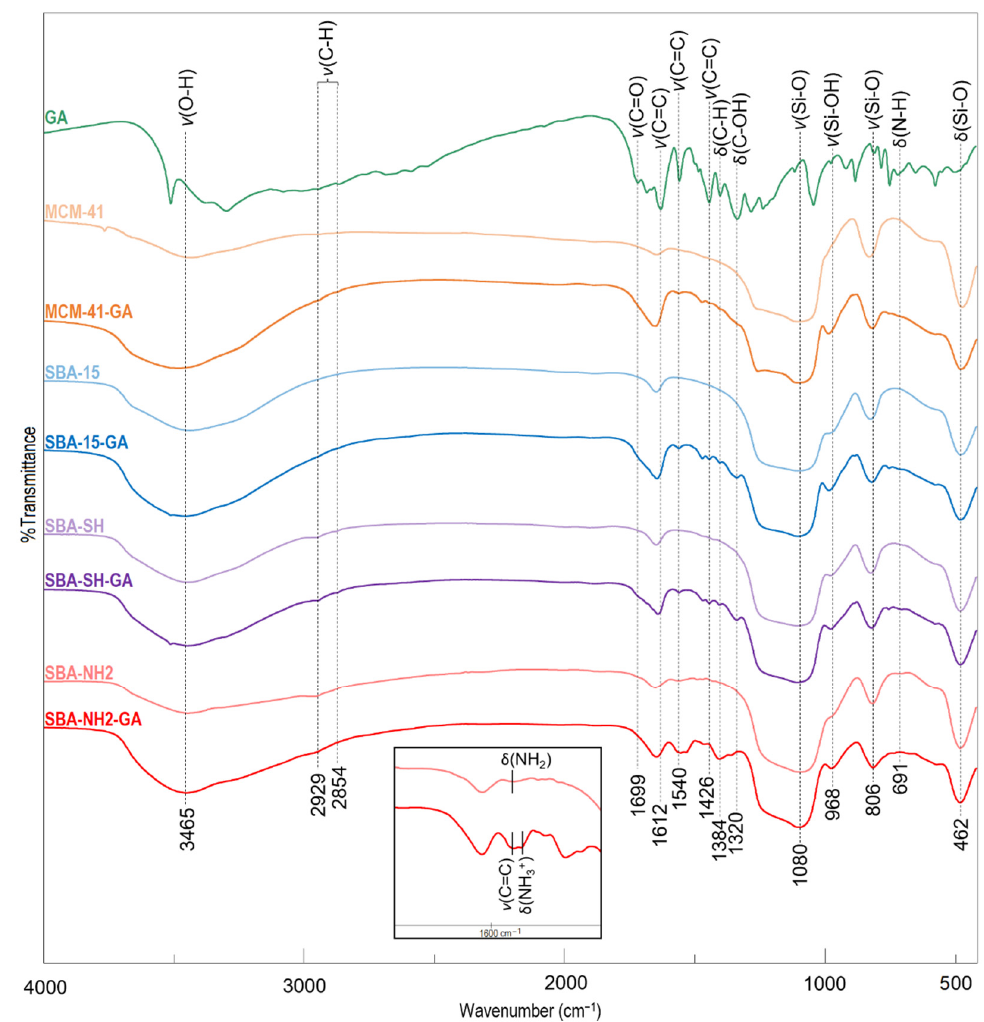
Figure 1. The FTIR spectra of GA ‐ loaded MSMs together with the reference samples (types of vibrations: υ —stretching; δ —bending).